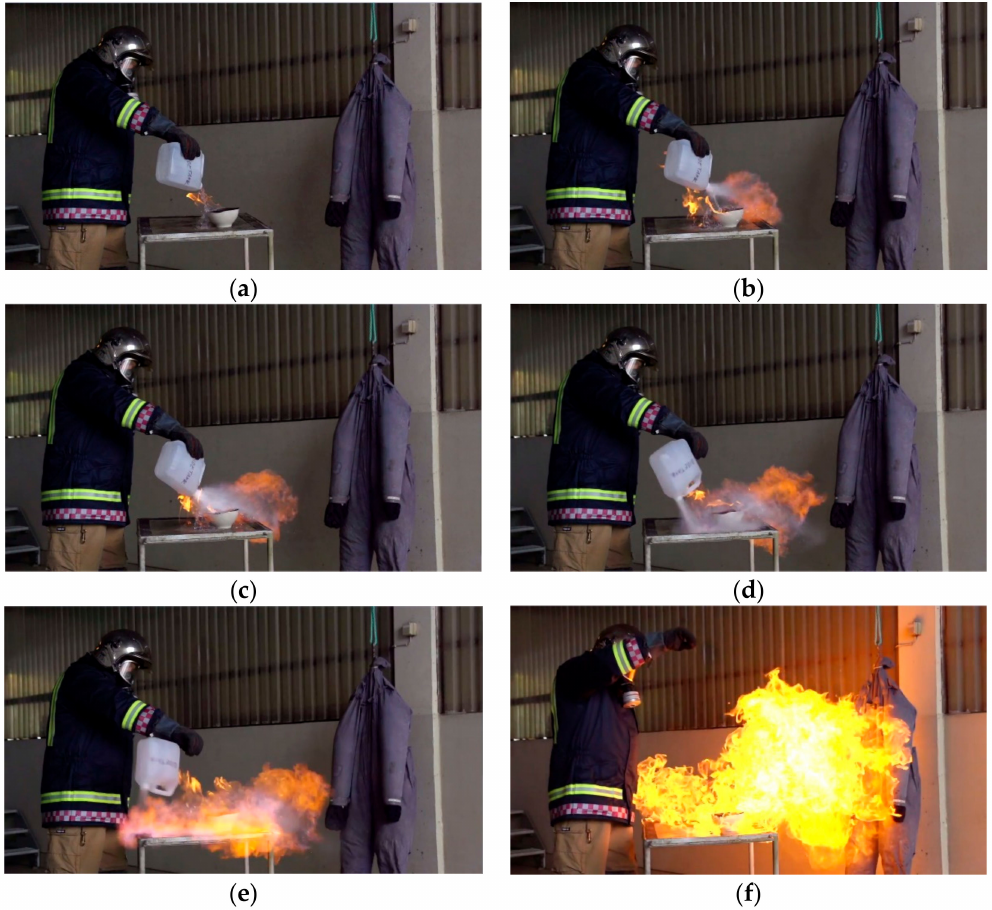
Figure 3. Demonstration of a 4 L ethanol container gas phase igniting at room temperature. The time sequence is about 0.5 s, i.e. ( a ) t = 0.1 s, ( b ) t = 0.2 s, ( c ) t = 0.3 s, ( d ) t = 0.4 s, ( e ) t = 0.5 s, ( f ) t = 0.6 s. (The Norwegian Directorate for Civil Protection ( DSB ) [32], reproduced with